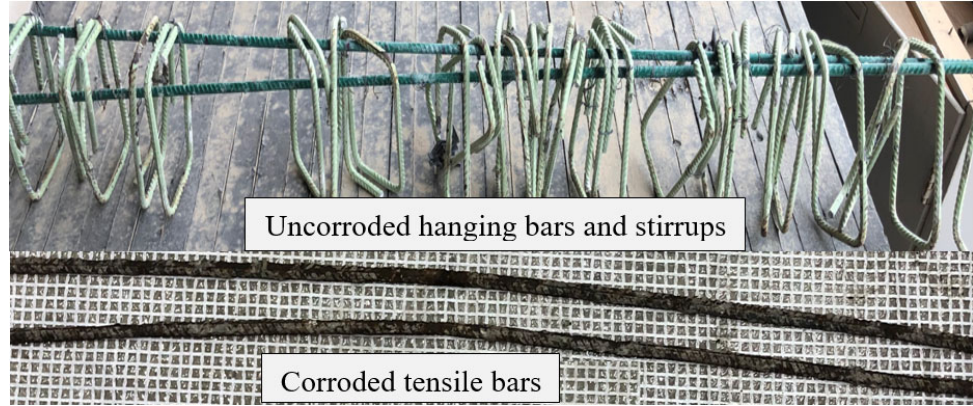
Figure 7. Longitudinal rebars and shear stirrups extracted from a corroded RC beam.